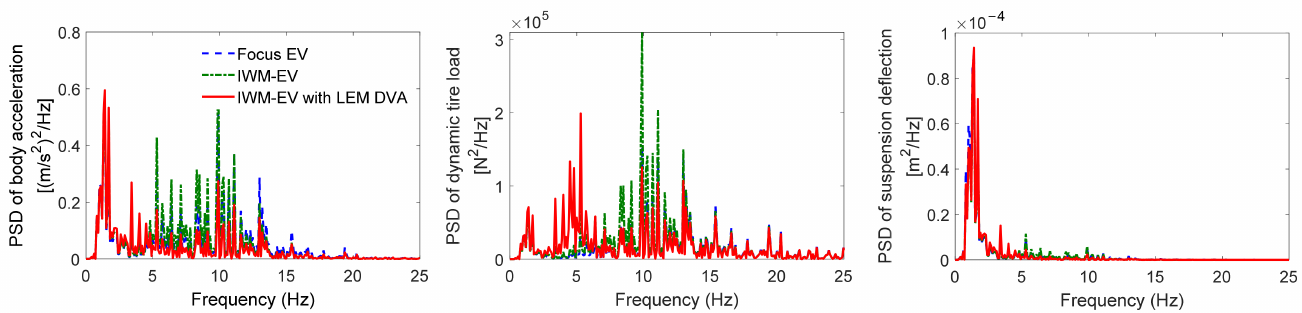
Figure 12. PSD of dynamic